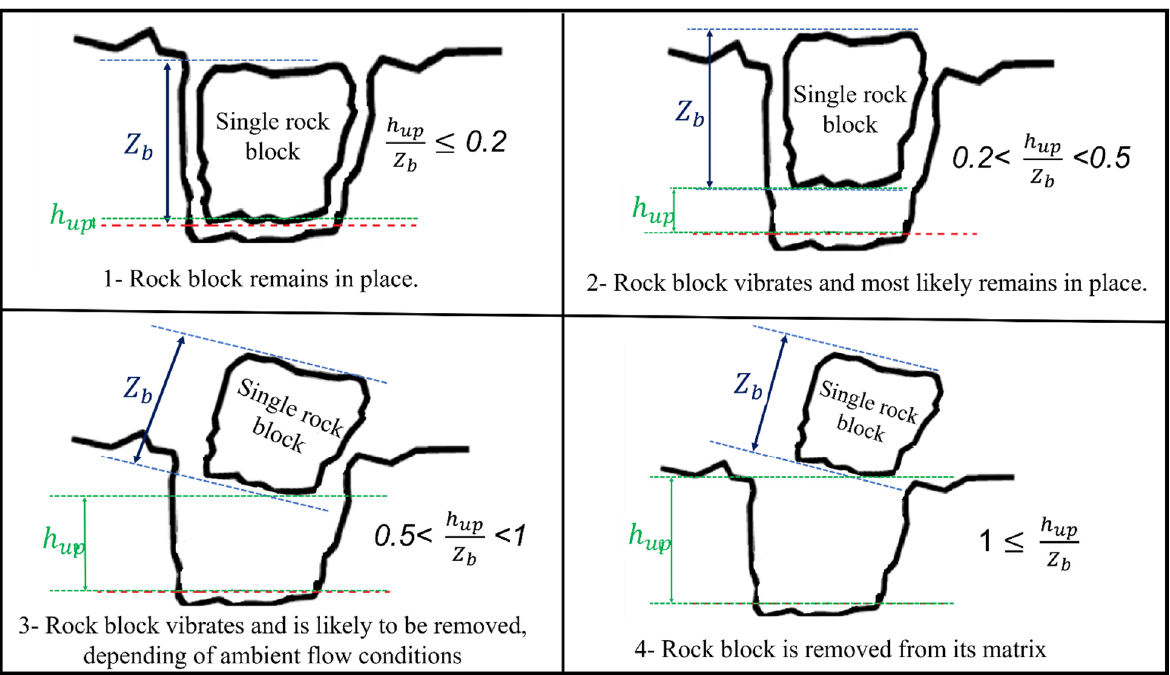
Figure 14. Proposed criteria to evaluate the rock scour potential by DI [63,70].